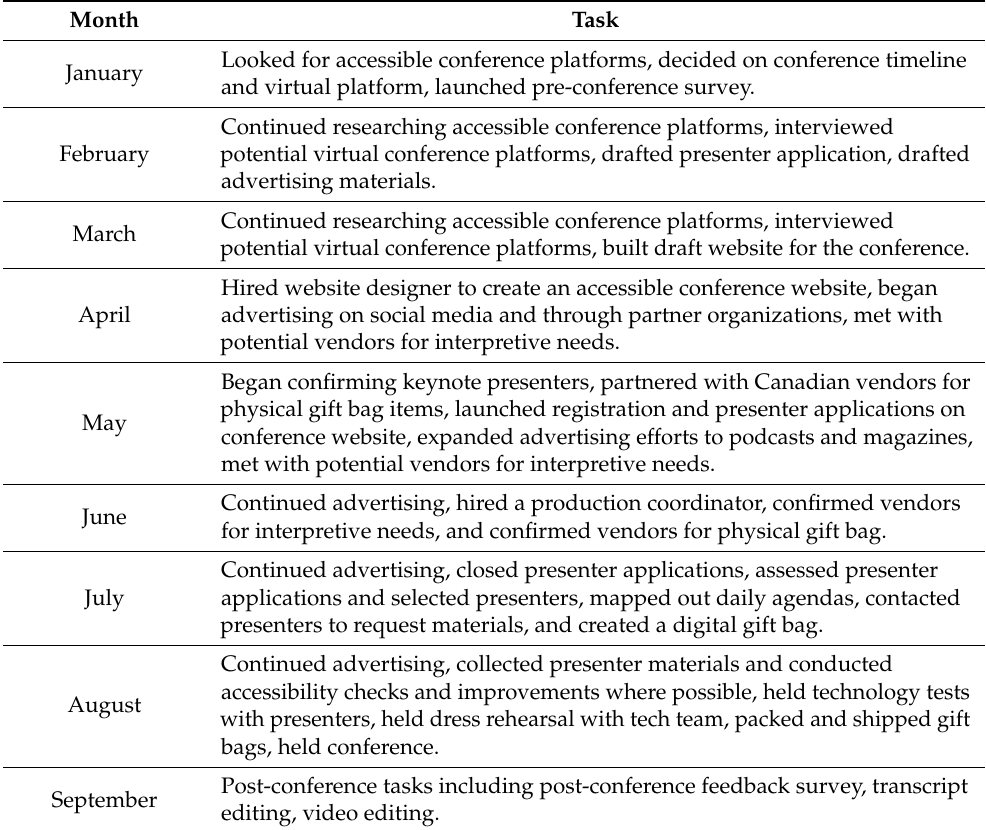
Table 1. Conference timeline from January to September